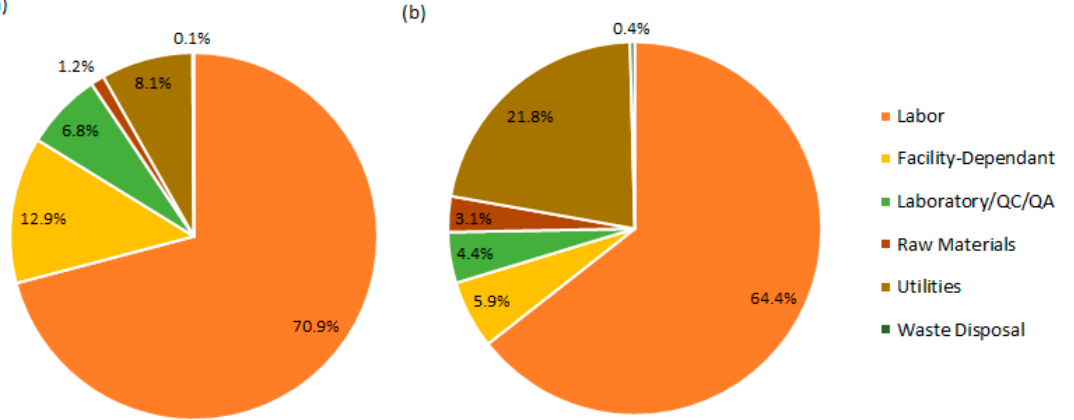
Figure 6. Operating cost breakdown for 3000 ( a ) and 30,000 ( b ) t/y simulations.